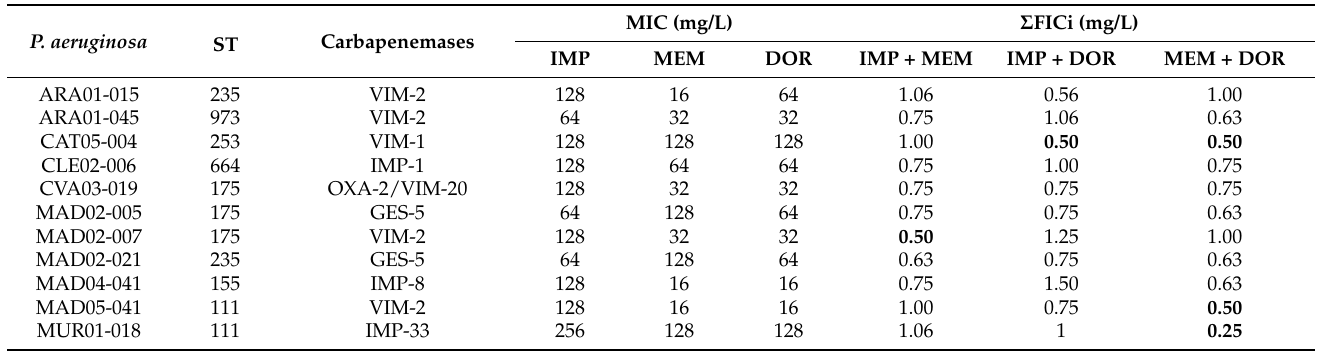
Table 1. MICs of imipenem, meropenem, and doripenem and fractional inhibitory concentration in- dexes (FICi) of dual carbapenem combinations for the eleven carbapenemase-producing Pseudomonas aeruginosa clinical